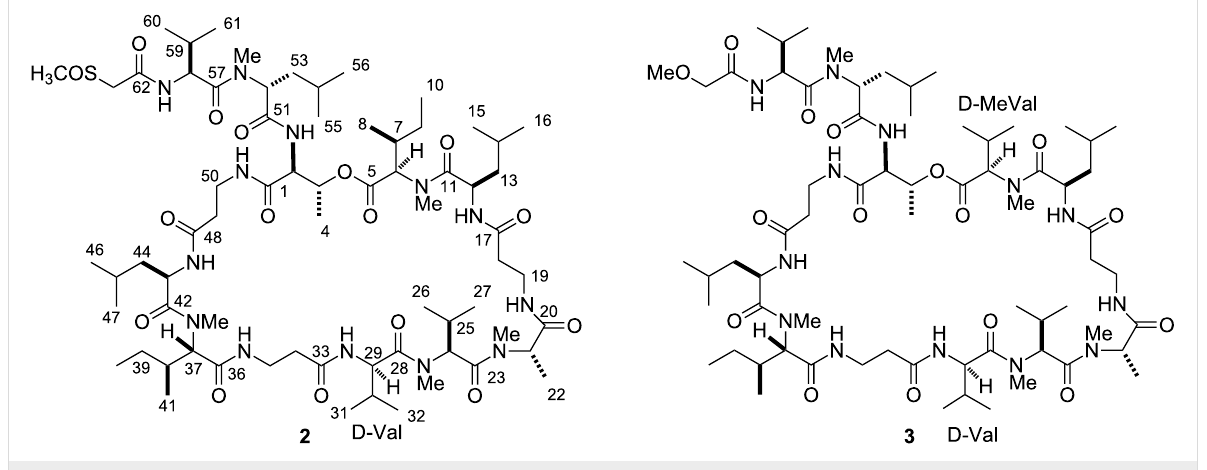
Figure 2: Structures of sulfinyltheonellapeptolide ( 2 ) and theonellapeptolide If ( 3 ).